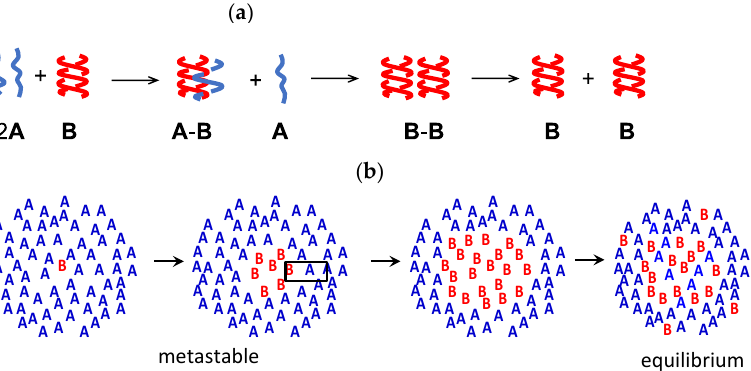
Figure 7. Schematic presentations of self-catalytic reaction 2 A + B → 2 B ( a ) at the molecular level and ( b ) at the molecular assembly level. Reproduced from ref. [52,53] with permission from Wiley. Seeding effect appears, in which the addition of B to 2 A significantly accelerates the chemical reaction. Spatially heterogeneous nature can appear because self-catalytic chemical reactions occur with molecules close each other (Figure 7b).